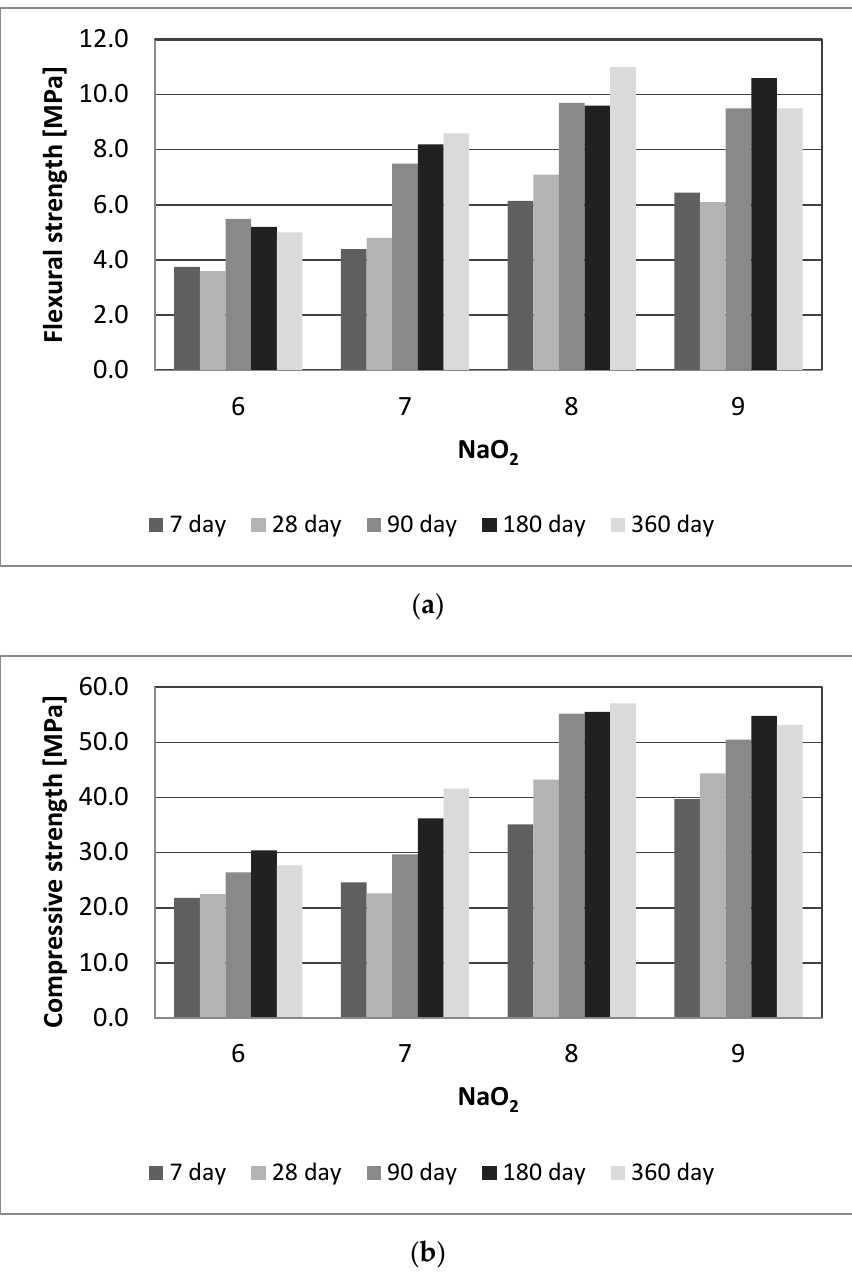
Figure 3. Flexural strengths ( a ) and compressive strengths ( b ) results with different Na 2 O amounts in the alkaline activator.